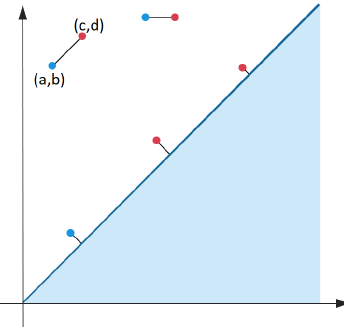
Figure 1. A matching between points in D 1 (plotted in blue) and D 2 (plotted in red). Some points of each diagram are matched to the